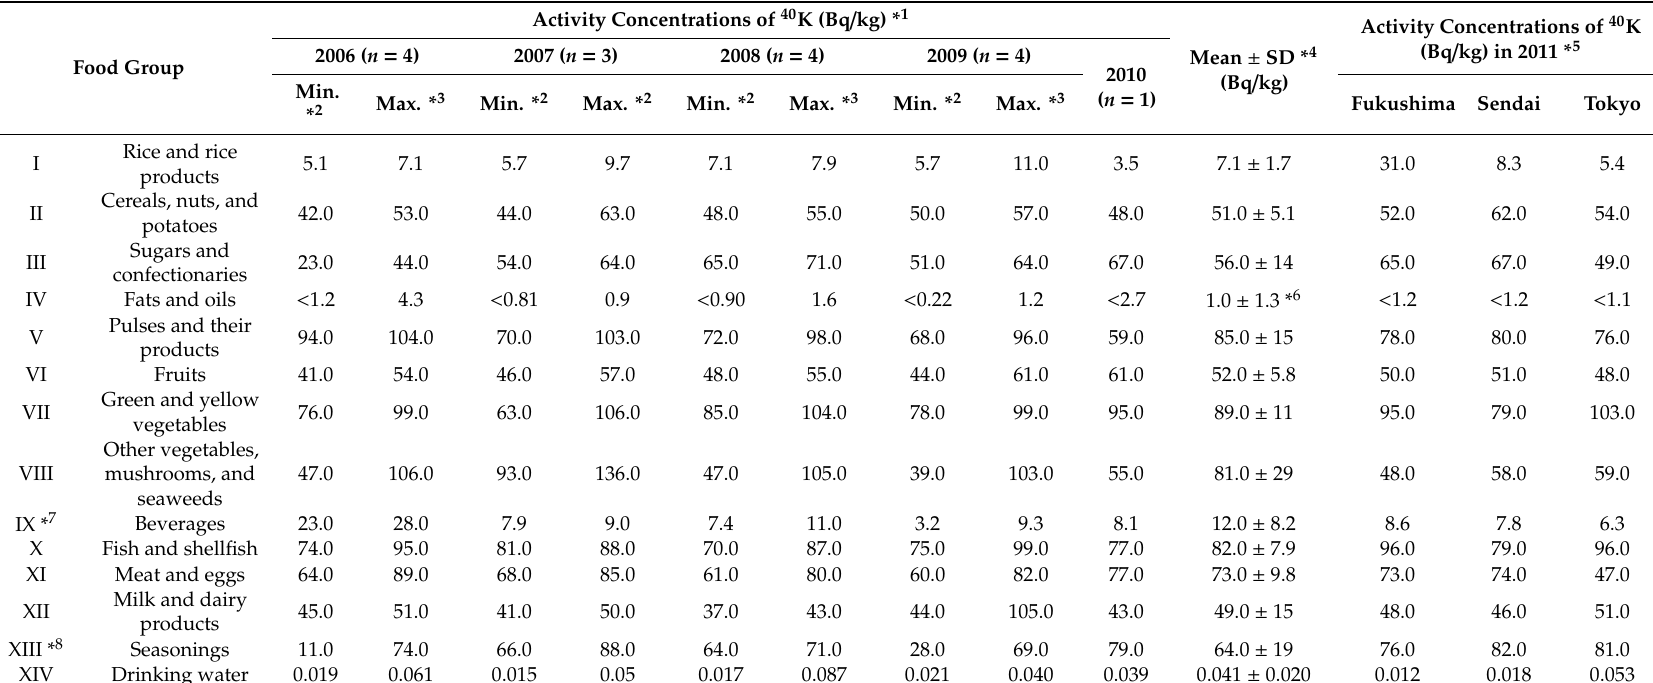
Table 3. Activity concentrations of 40 K in Japanese total diet study samples from 2006 to